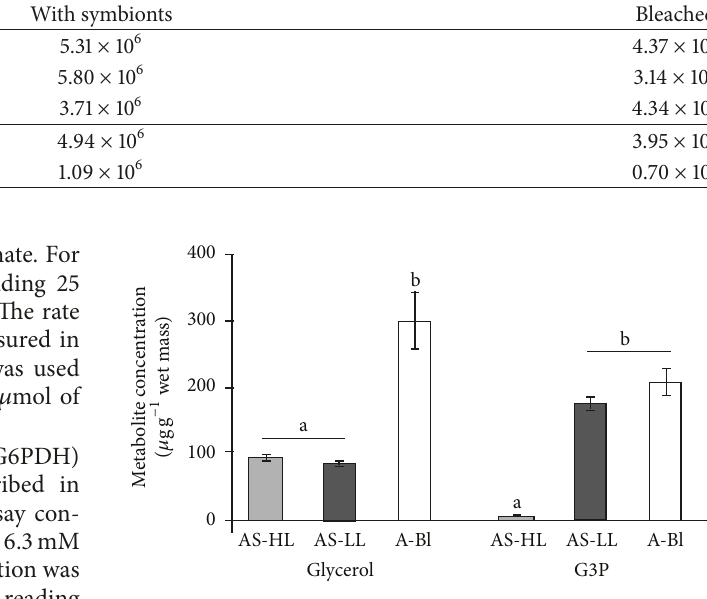
Figure 1: Glycerol levels measured in symbiotic and bleached anemones. Animals in the symbiotic state were maintained at two light conditions (HL = 250 𝜇 mol photons cm −2 s −1 ; LL = 50 𝜇 mol photons cm −2 s −1 ). Bleached animals were maintained in the dark. Columnsrepresenttheaverageofthreeindependentdeterminations ± SD (bars). Values are in 𝜇 g g −1 of wet mass. Small letters group treatments that were similar for each metabolite (Tukey HSD, 𝑝 <